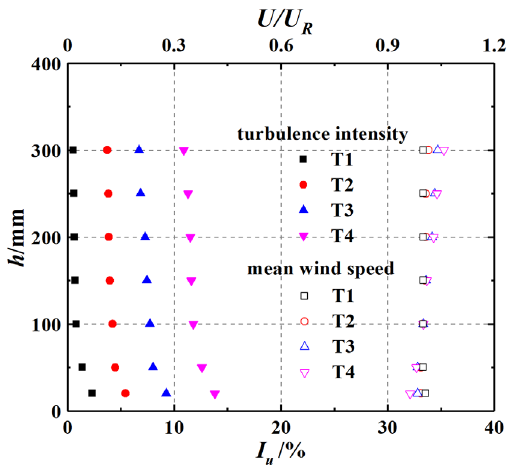
Figure 1. Mean wind speed and turbulence profiles.